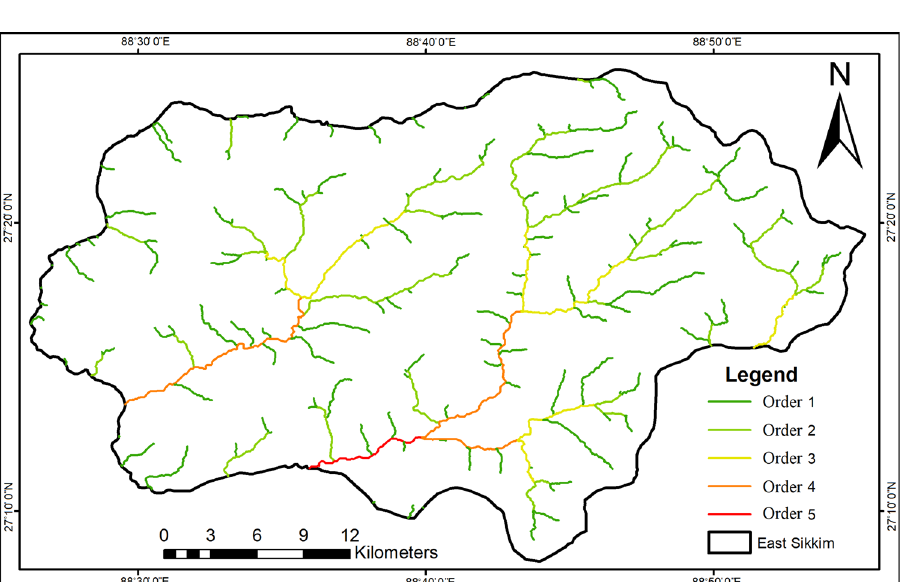
Fig. 8 Stream order map of